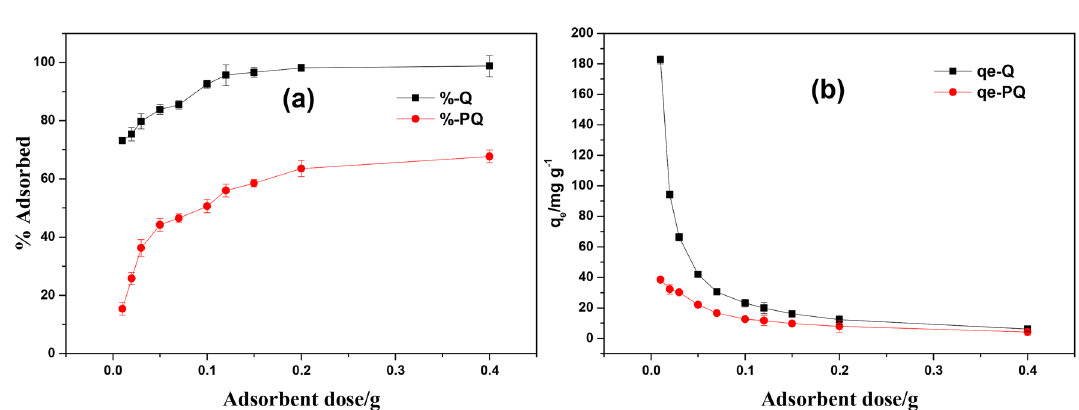
Figure 9. Plots of kinetics models fitted to the experimental data (purple) for the adsorption of Cr(VI) onto ( a ) PQ and ( b ) Q [pseudo-first-order (blue), pseudo-second-order (red), intraparticle diffusion (green), Elovich (black)].